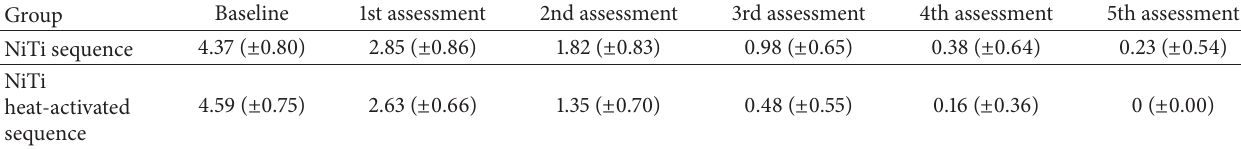
Table 2: Mean and standard deviation values of Little’s index of irregularity during treatment phases.